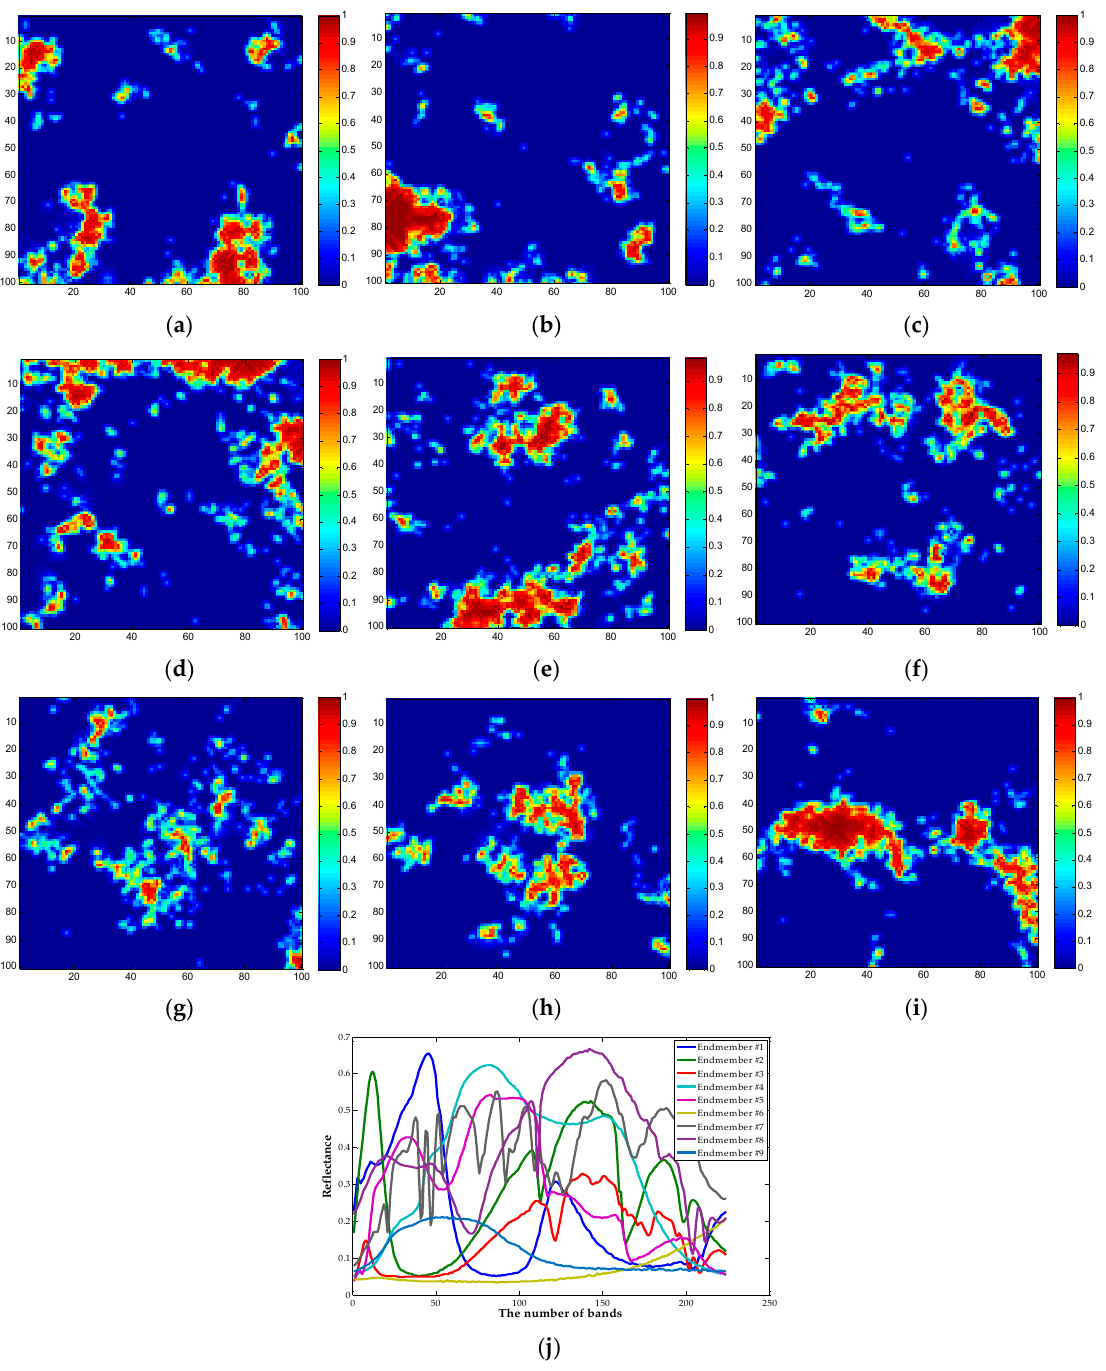
Figure 4. Simulated Data Cube 2 (DC-2). ( a ) Abundance map of #1. ( b ) Abundance map of #2. ( c ) Abundance map of #3. ( d ) Abundance map of #4. ( e ) Abundance map of #5. ( f ) Abundance map of #6. ( g ) Abundance map of #7. ( h ) Abundance map of #8. ( i ) Abundance map of #9. ( j ) The nine spectral curves.